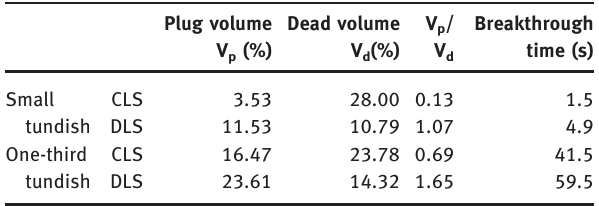
Table 1: RTD characteristics of studied cases in two types of